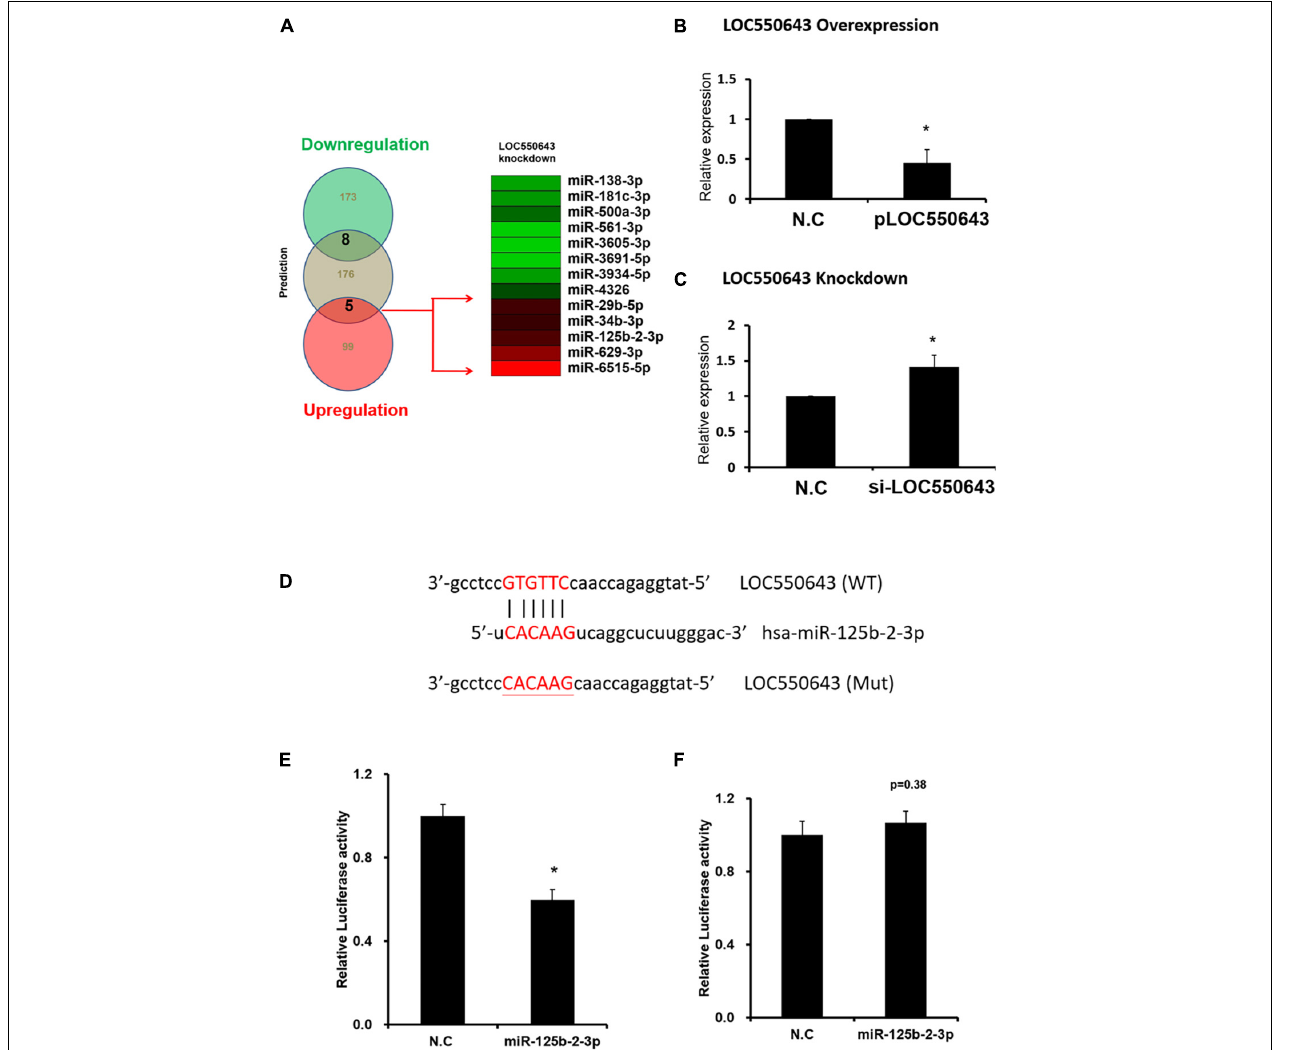
FIGURE 8 | Regulation of miR-125b-2-3p expression through direct interaction with LOC550643 . (A) Identification of LOC550643 -sponged miRNA candidates through TargetScan and small RNA profiles. (B) Expression levels of miR-125b-2-3p examined in MDA-MB-231-P cells with ectopic LOC550643 expression (real-time PCR). (C) Expression levels of miR-125b-2-3p assessed in MDA-MB-231-IV2-1 cells with si- LOC550643 transfection by real-time PCR. (D) Schema of luciferase constructs. The miR-125b-2-3p targeting sequence in the LOC550643 sequence is represented in the upper panel, and the mutated sequence of its binding region is in red. (E,F) Relative luciferase activity of pMIR-LOC550643-wt and pMIR-LOC550643-mut identified in breast cancer cells transfected with miR-125b-2-3p mimics and scramble control. All experiments were carried out in triplicate. Using Student’s t -test to analyze our data and p < 0.05 was considered significant (* p < 0.05, ** p < 0.01, and *** p <